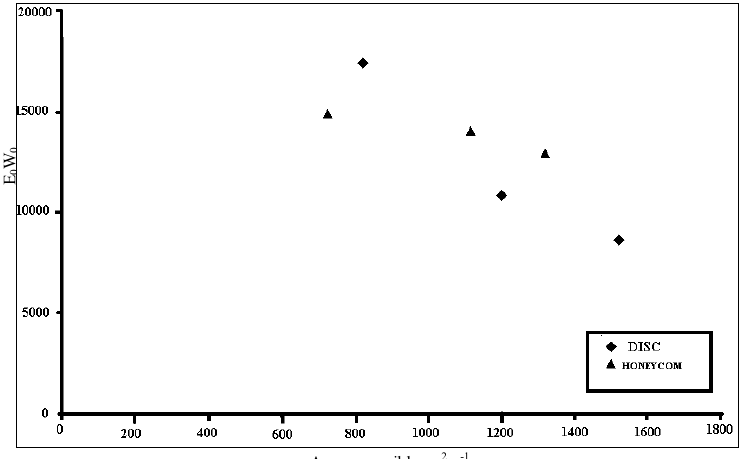
Figure 6. Product E area